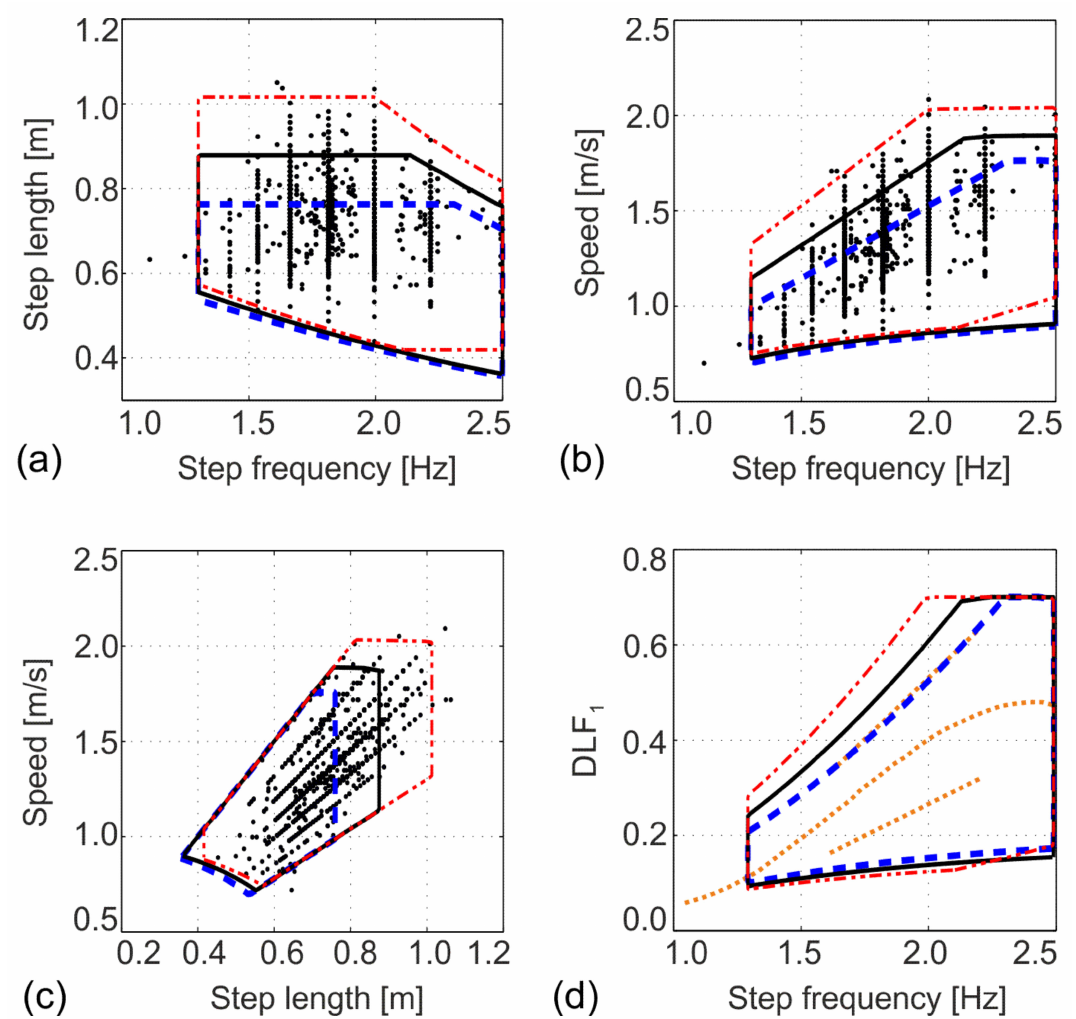
Figure 9. Relationships between ( a ) step length and step frequency, ( b ) speed and step frequency, ( c ) speed and step length, and ( d ) DLF 1 and step frequency, in the IPM. Blue dashed line: l = 0.9 m, black solid line: l = 1.037 m, red chain line: l = 1.2 m. Black dots: experimental data from Figure 4. Dotted lines: experimental data (mean and mean ± 2 STD) by Kerr